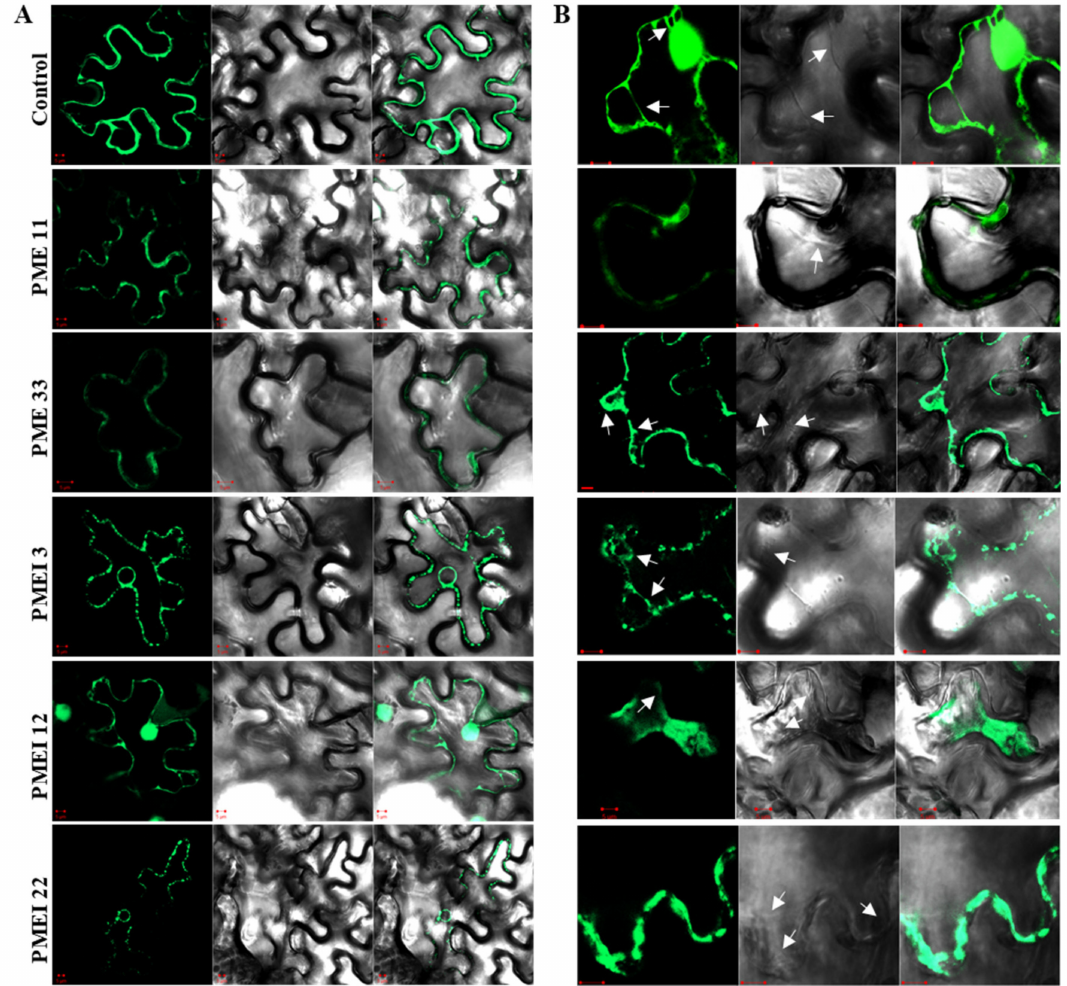
Figure 7. Subcellular localization of green fluorescent protein (GFP)-tagged OsPMEs and OsPMEIs in tobacco epidermal cells using confocal fluorescence microscopy. ( A ) Control-GFP, and five pollen-specific OsPME and OsPMEI signals were observed in tobacco epidermal cells. The bright image (left panel), the corresponding fluorescent signals (center panel), and a merged image (right panel). ( B ) Plasmolyzed tobacco epidermal cells. Cells were treated with 1 M NaCl, and arrows indicate the plasmolyzed Hechtian strands. The order of picture is the same as in A. Scale bars = 5 µ